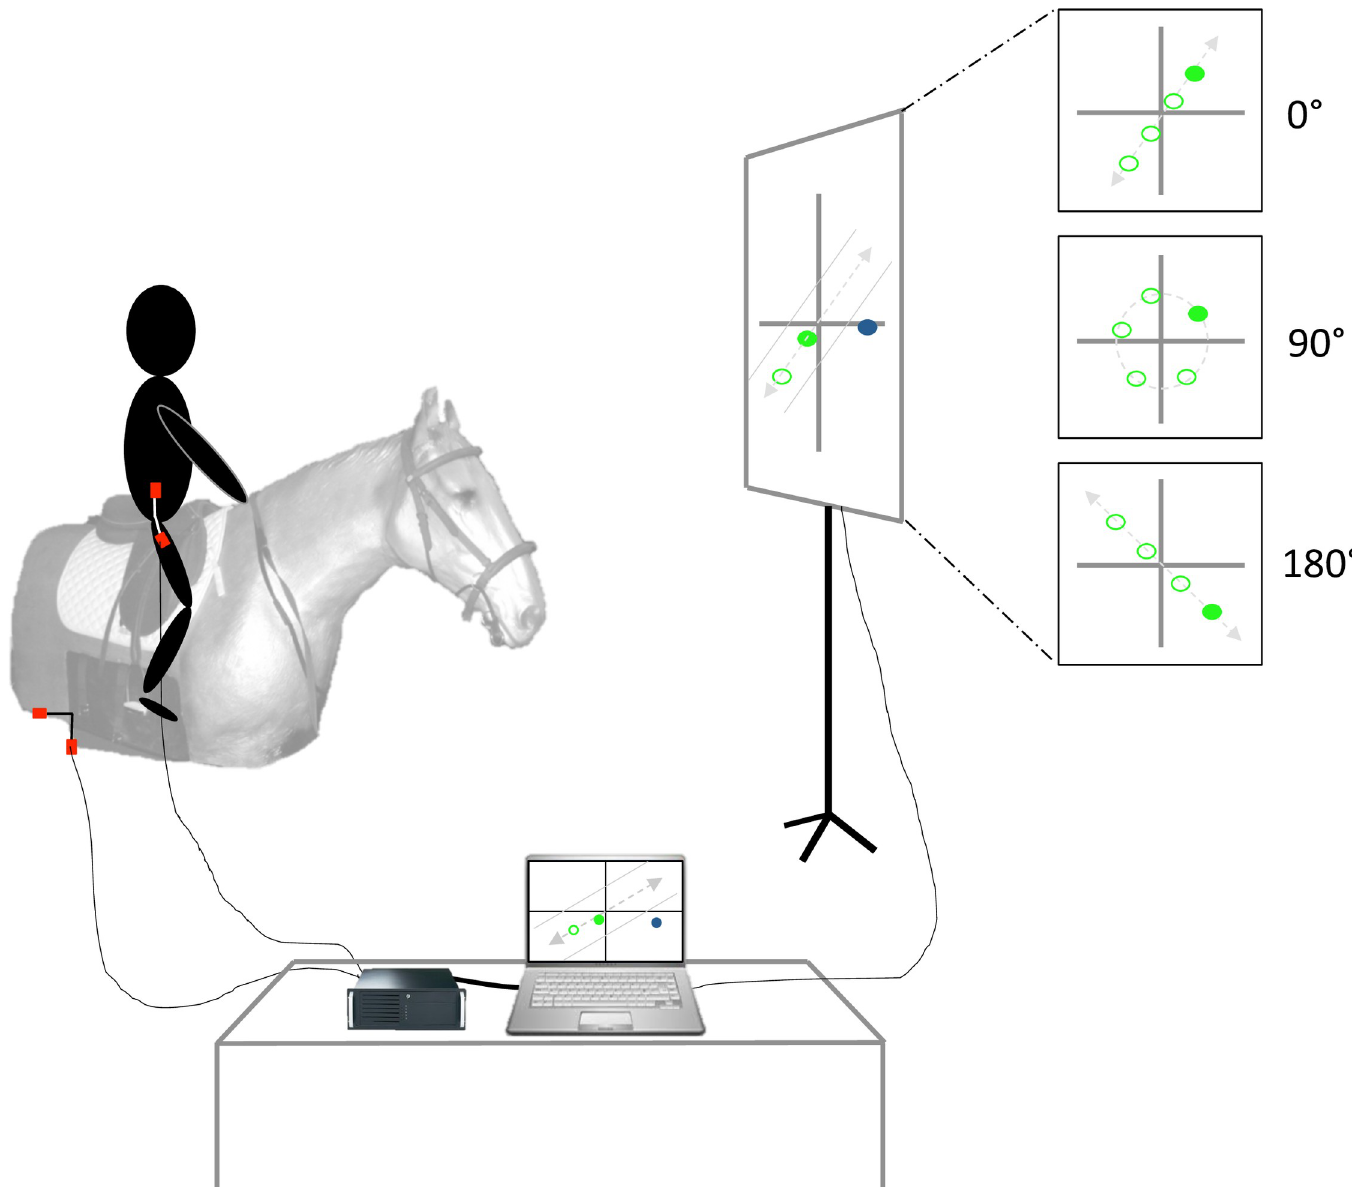
Fig 2. Experimental set-up. Each participant performed 4 different tasks on the mechanical horse; the first coordination was a 180˚ coordination without feedback and the 3 others were 0˚, 90˚ and 180˚ coordination with a visual feedback, corresponding to the online postural activity of participant.